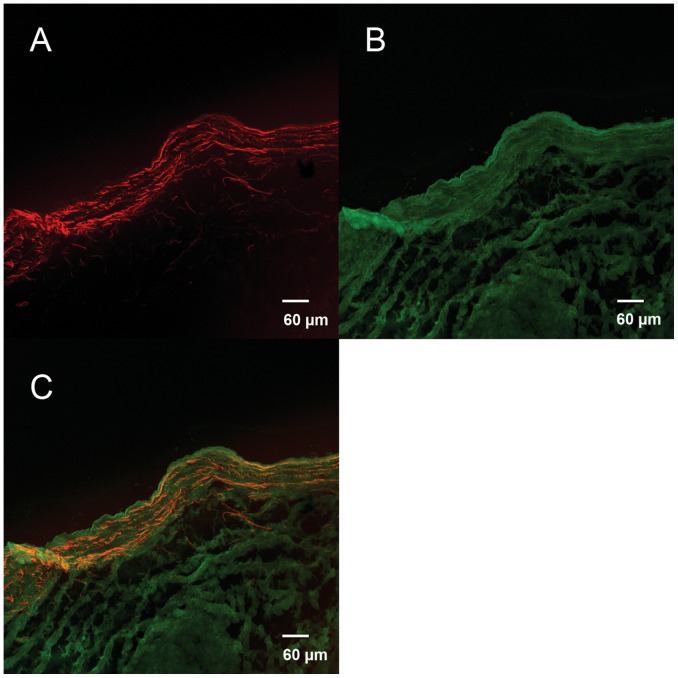
The fluorescence mainly distributed on the surface of the PDAV.The red fluorescence indicated the presence of VEGF bound to HEP-PDAV (A), while the green fluorescence distributed on the surface of the tissue cross section represent HEP bound to the whole the decellularized valve (B). The fluorescence between FITC and Rhodamine B was non-overlapping, indicating that the both HEP and VEGF were mutually bound to the PDAV (C). (A–C) Scale bars: 60 µm.